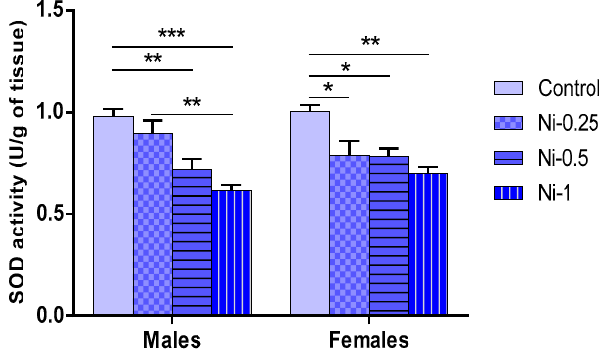
Figure 8. Changes in Superoxide Dismutase (SOD) activity in hippocampus, expressed as U/g of tissue in male and female rats after 8 weeks of treatment with 0.9% of NaCl (Control), 0.25 mg/kg (Ni-0.25), 0.5 mg/kg (Ni-0.5), and 1 mg/Kg (Ni-1) of Ni. Results are represented as mean ± SEM. The significance level is 0.05. * p < 0.05, ** p < 0.01, *** p < 0.001.